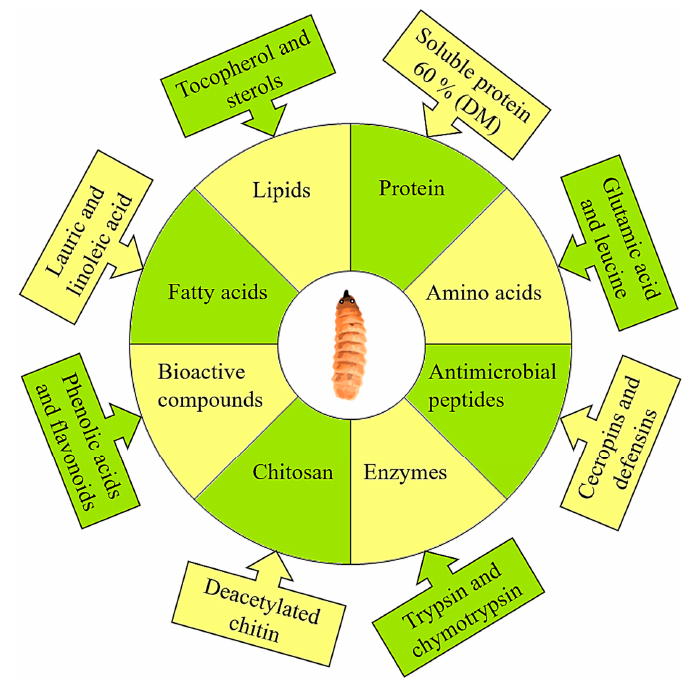
Figure 7. Constituents retrievable via BSFL biorefinery.